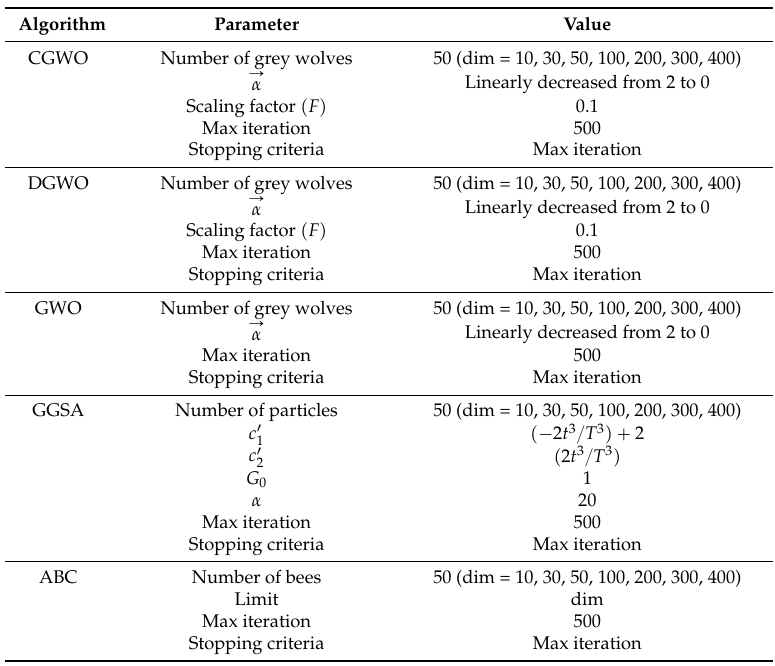
Table 3. Initial parameters of algorithms (where T indicates the maximum number of interactions; t is the current